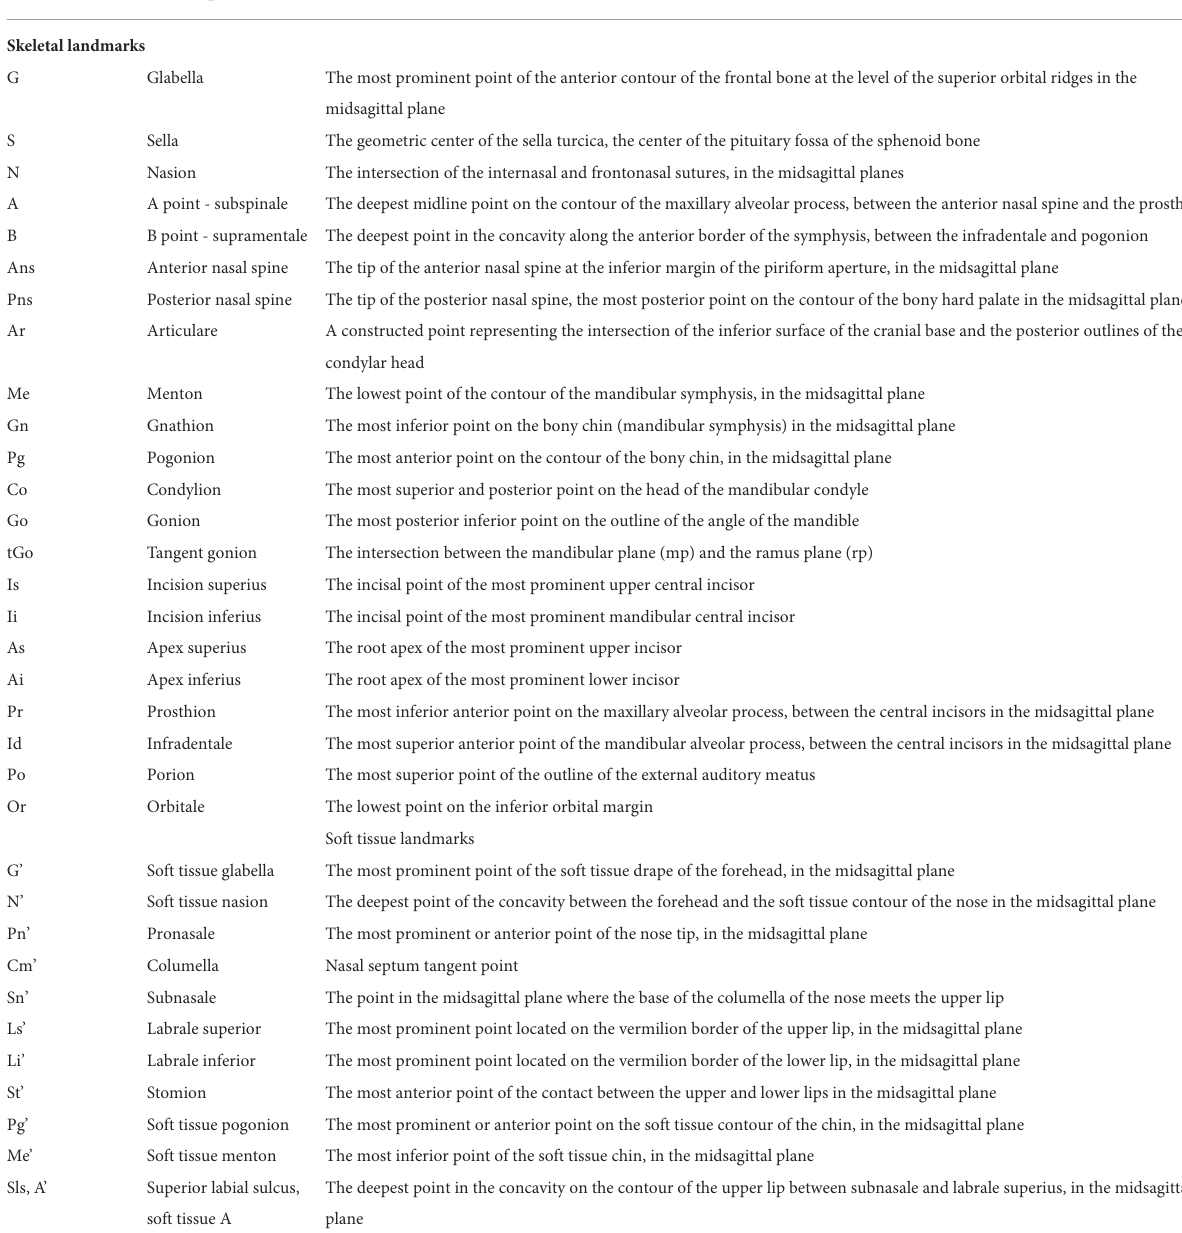
TABLE 1 Definition of the skeletal and soft tissue cephalometric